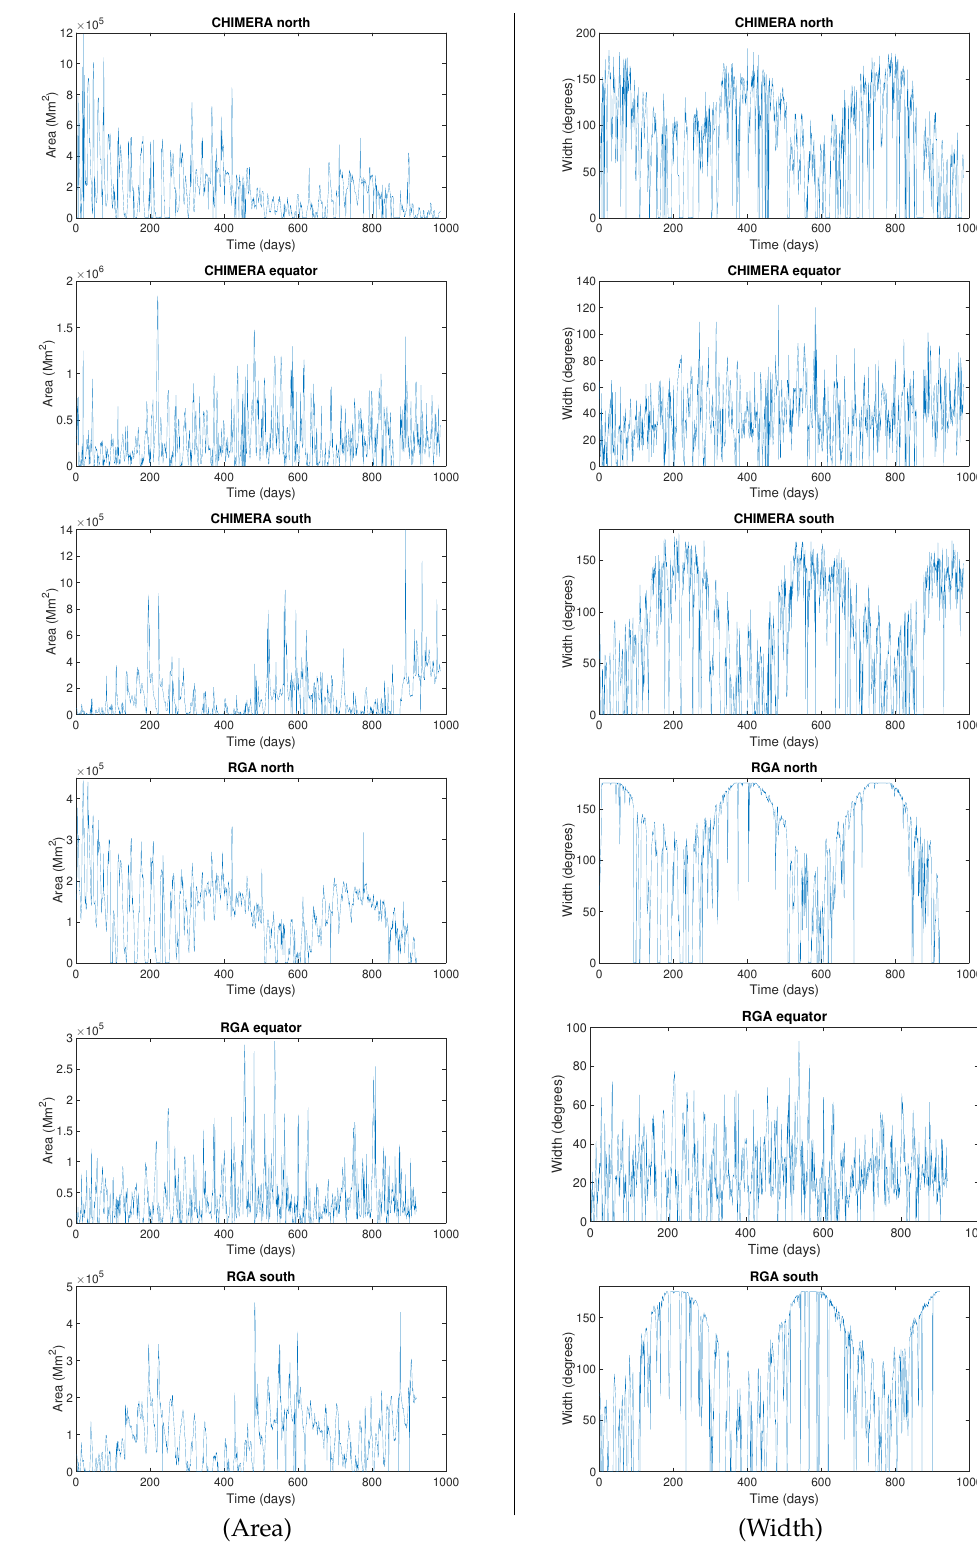
Figure 4. Columns represent the initial time series of the daily maximal area and maximal longitudinal width obtained by two methods of the CH segmentation at different zones of the